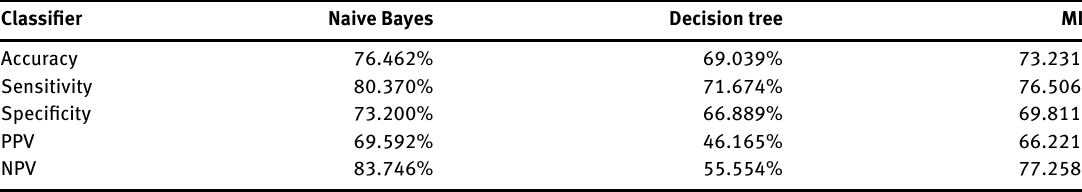
Table 3: Naive Bayes, Decision Tree, and MLP Results.